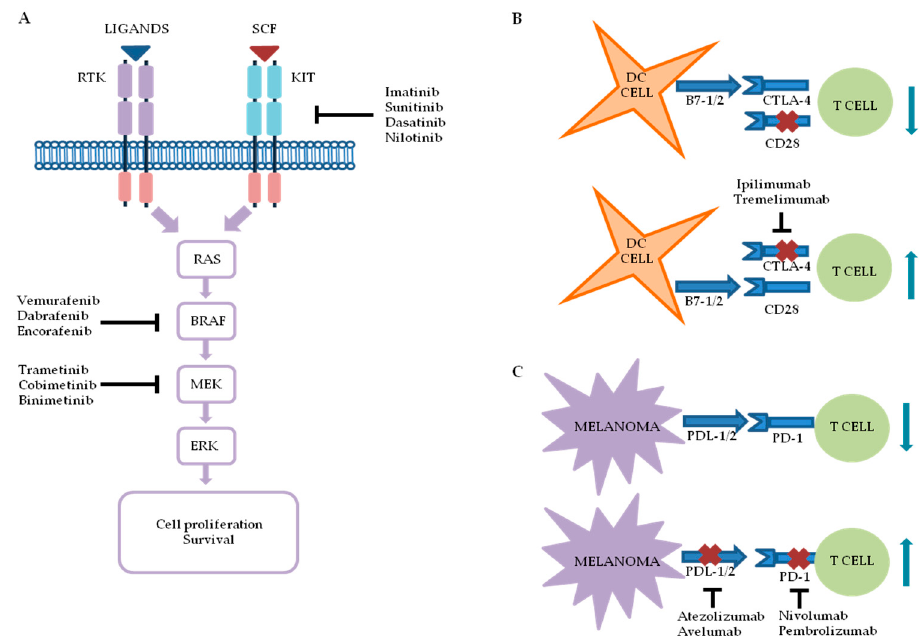
Figure 1. Schematic representation of the most important approaches to melanoma treatment. ( A ) Mitogen-activated protein kinase (MAPK) signaling is often deregulated in melanoma and, for this reason, several drugs against the components of the pathway have been developed. Although less frequently mutated, the v-kit Hardy–Zuckerman 4 feline sarcoma viral oncogene homolog (KIT) receptor tyrosine kinase, represents another molecular target for certain melanomas, and KIT inhibitors can be used in combination with chemotherapy or immunotherapy. ( B ) Cytotoxic T-lymphocyte-associated protein 4 (CTLA-4), interacting with B7 ligands present on the surface of dendritic cells (DCs), prevents the activation of T lymphocytes. The functional block of CTLA-4 mediated by monoclonal antibodies supports the interaction between B7 ligands and CD28, positive regulator receptor of the T lymphocyte activity. ( C ) Melanoma cells usually express elevated levels of programmed death ligand (PDL) 1 and 2, which, through interaction with programmed cell death protein 1 (PD-1) receptor on T cells, block their activation. Pharmacological inhibition of the PD-1 axis restores T cells’ ability to recognize and kill tumor